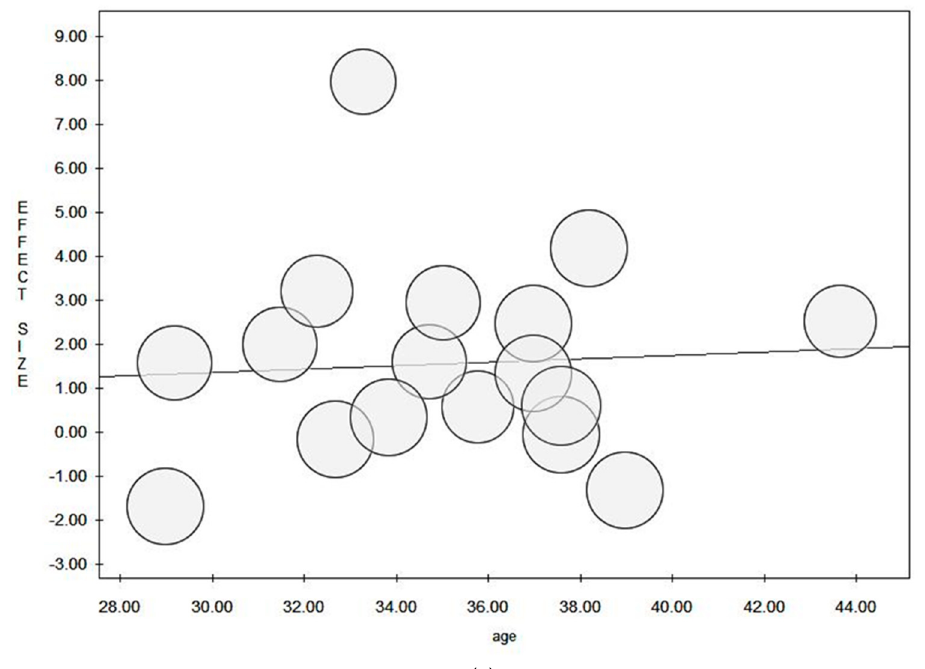
Figure 10. ( a ) Moderator analysis by year of publication (the first group consisted of studies until 2004, the second between 2005 and 2010, and the third after 2010 until today); ( b ) meta-regression analysis by duration of exposure; and ( c ) meta-regression analysis by mean age of exposed groups, assessing the comet assay on lymphocytes cells among professionals occupationally exposed to antineoplastic drugs (ANDs).